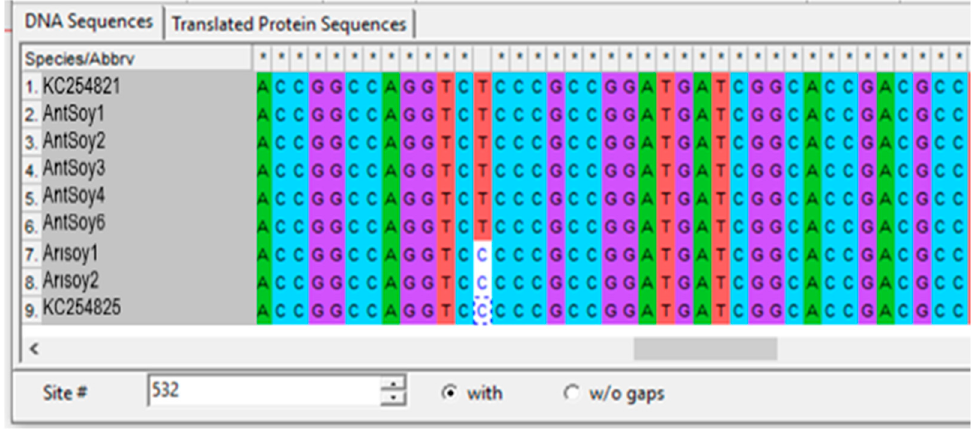
Figure 3. Alignment image made with Mega-X program. KC254821 (1) and KC254825 (9) resistant and sensitive plant reference sequence, respectively. 2, 3, 4, 5 and 6 were the progeny of AntSoy. 7 and 8 were herbicide sensitive Ar ı soy variety (the wild type) .